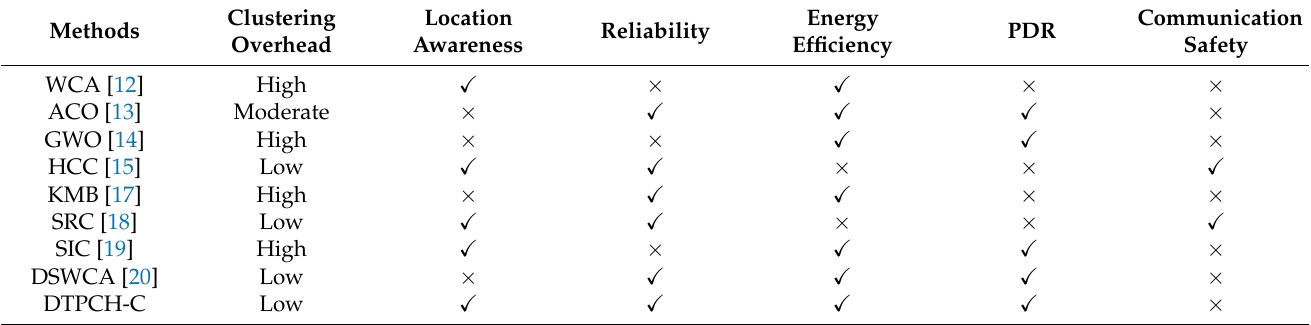
Table 1. DTPCH-C performance positioning with other clustering schemes in